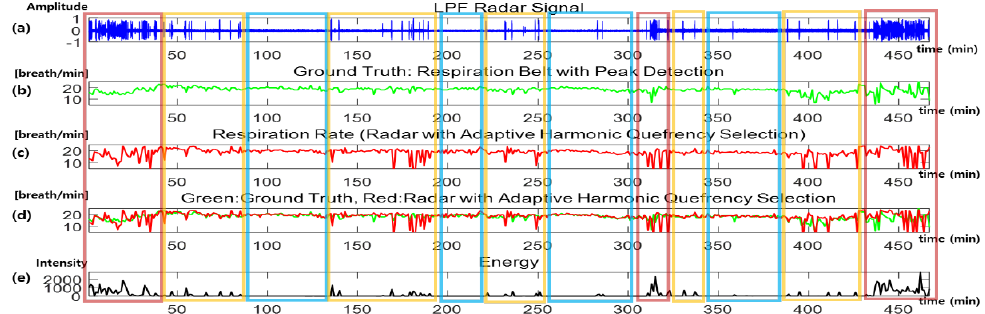
Figure 8. Respiration rate detection over long periods: ( a ) radar signal, ( b ) respiration rate from the respiration belt (ground truth), ( c ) respiration rate from the radar (proposed method), ( d ) comparison of the respiration rates from the respiration belt and radar signals, and ( e ) movement energy. LPF: Low-Pass Filter.